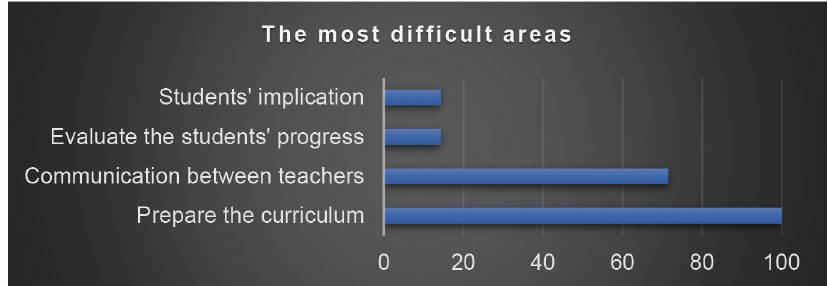
Figure 2. Distribution of activities by level of difficulty according to teachers’ responses